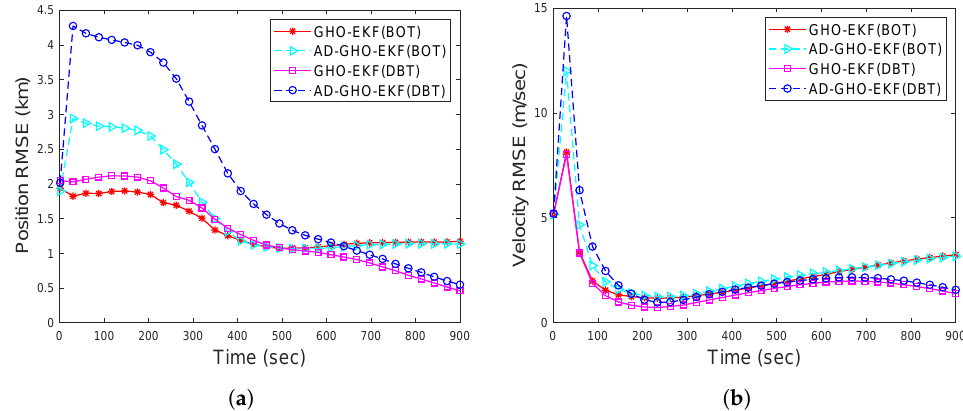
Figure 14. RMSEs of the ( a ) position; ( b ) velocity of the BOT and DBT for maneuvering